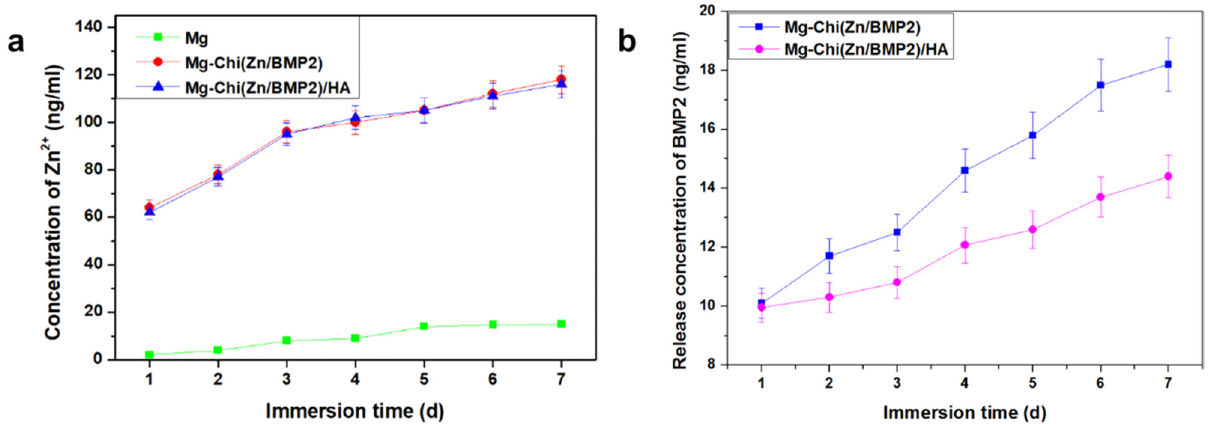
Figure 2: The release pro fi les of Zn 2 + ( a ) and BMP2 ( b ) over 7